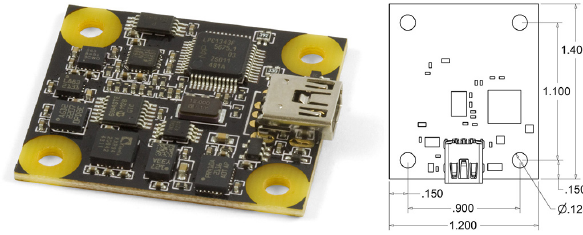
Figure 3. MEMS model 1044_0 (3/3/3 PhidgetSpatial Precision High Resolution) produced by the Canadian company Phidget Inc.; the reported measures are in